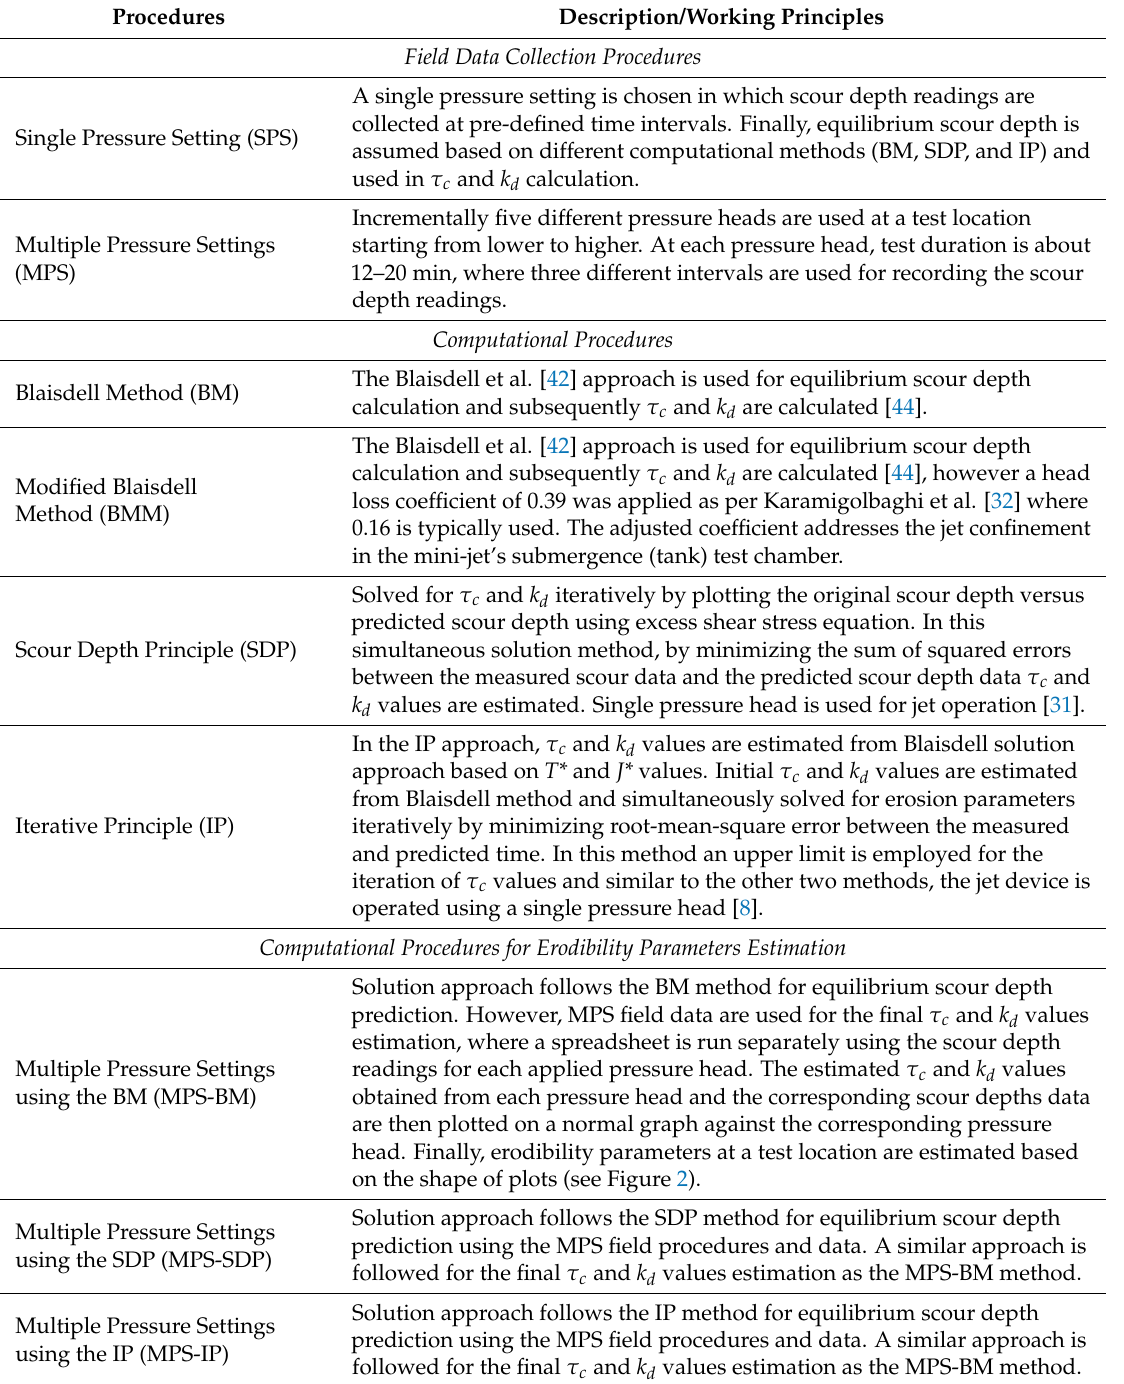
Table 1. Procedural summaries for field data collection and computation for erodibility parameters using the mini-jet